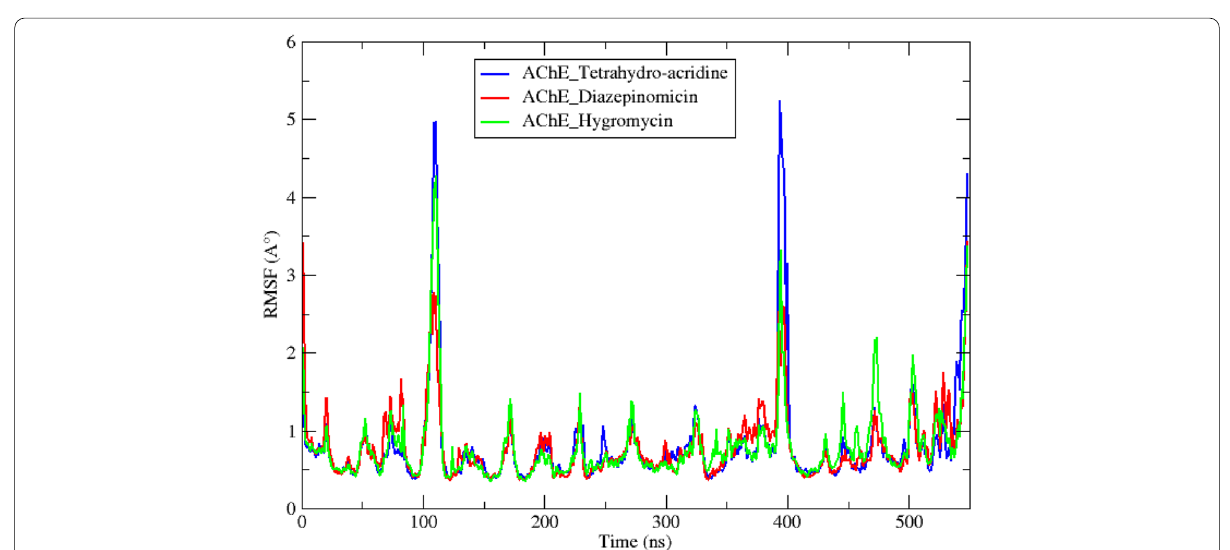
Fig. 5 RMSF of the reference and the two top complexes during 50-ns MD